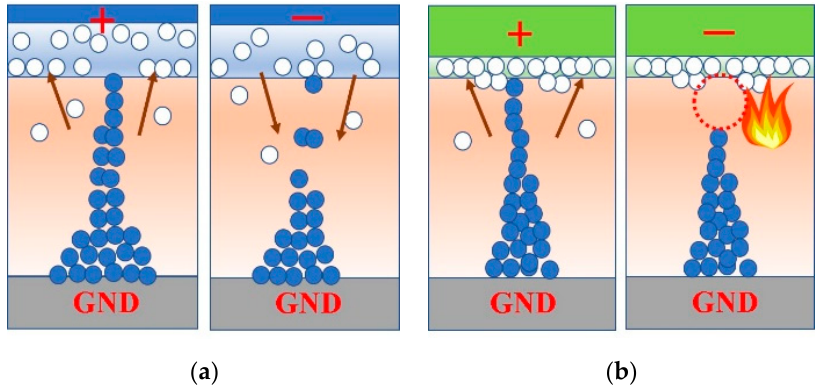
Figure 5. ( a ) Schematic of set and reset process of the IGO RRAM with TE of Ti. When a positive bias applied to the TE, the oxygen vacancies were arrayed by the induced electric field. With the aid of the TiO x layer, the set process is easier to approach. ( b ) The schematic of how Joule heat effect impact the filament when AlO x formed. Since the dense AlO x layer was formed, current crowding effect may happen at the interface between TE and IGO layer, which generate a large current and finally rupture the filament.